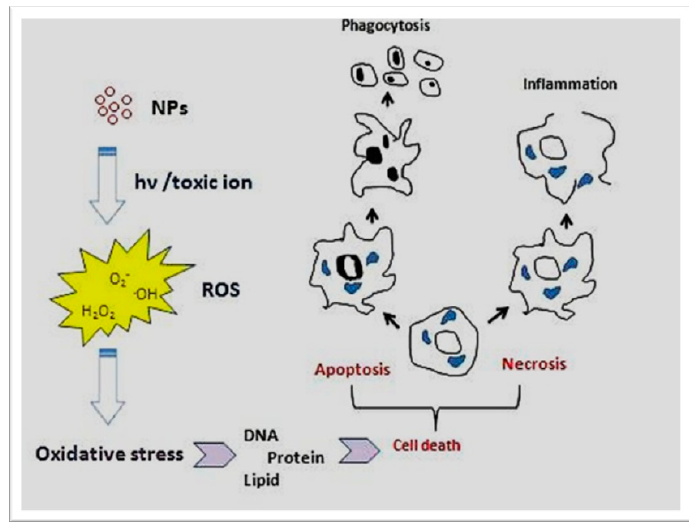
Figure 4. Major molecular and cellular mechanisms involved in the toxicity of (metallic) NPs [100]. (Reproduced with permission).